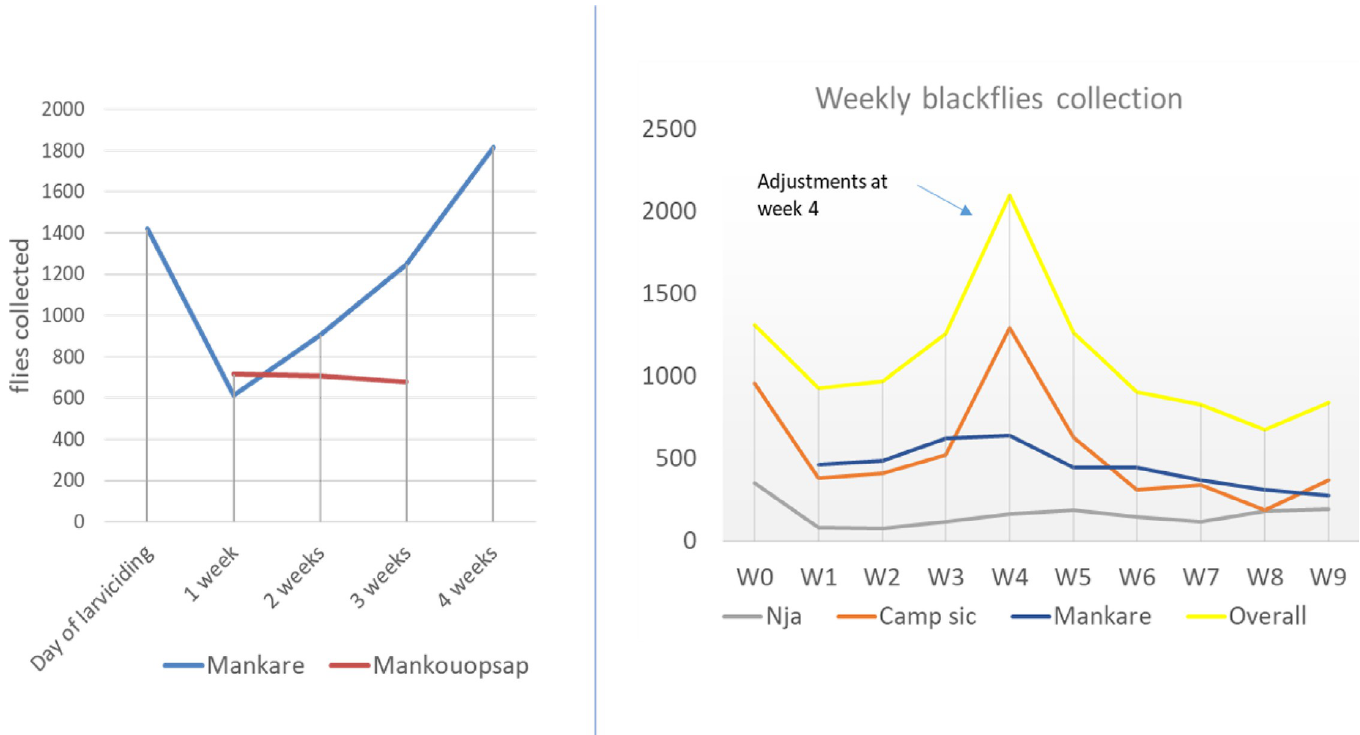
Fig 2. Fly collection during rounds one and two ground larviciding.